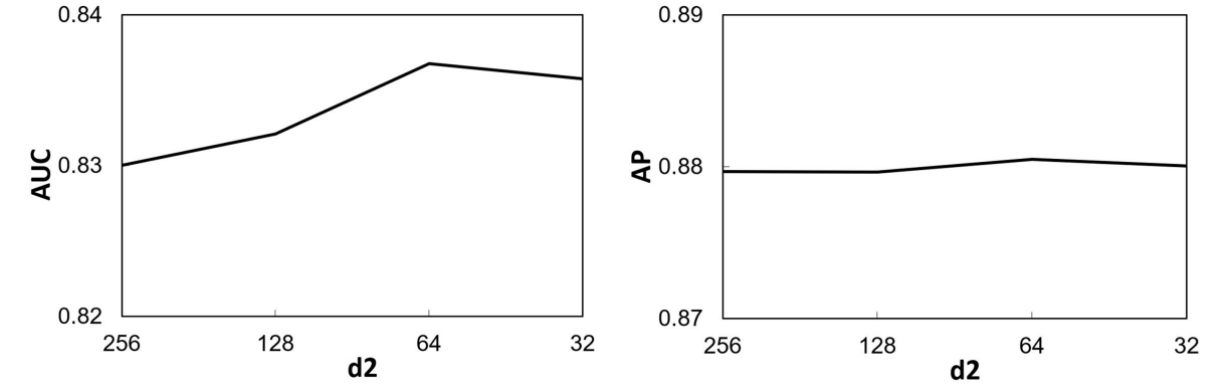
Figure 7. Variation in the area under the receiver operating characteristic curve (AUC) and average precision (AP) with the dimensionality d2 of the second hidden layer in neural network 1 and neural network